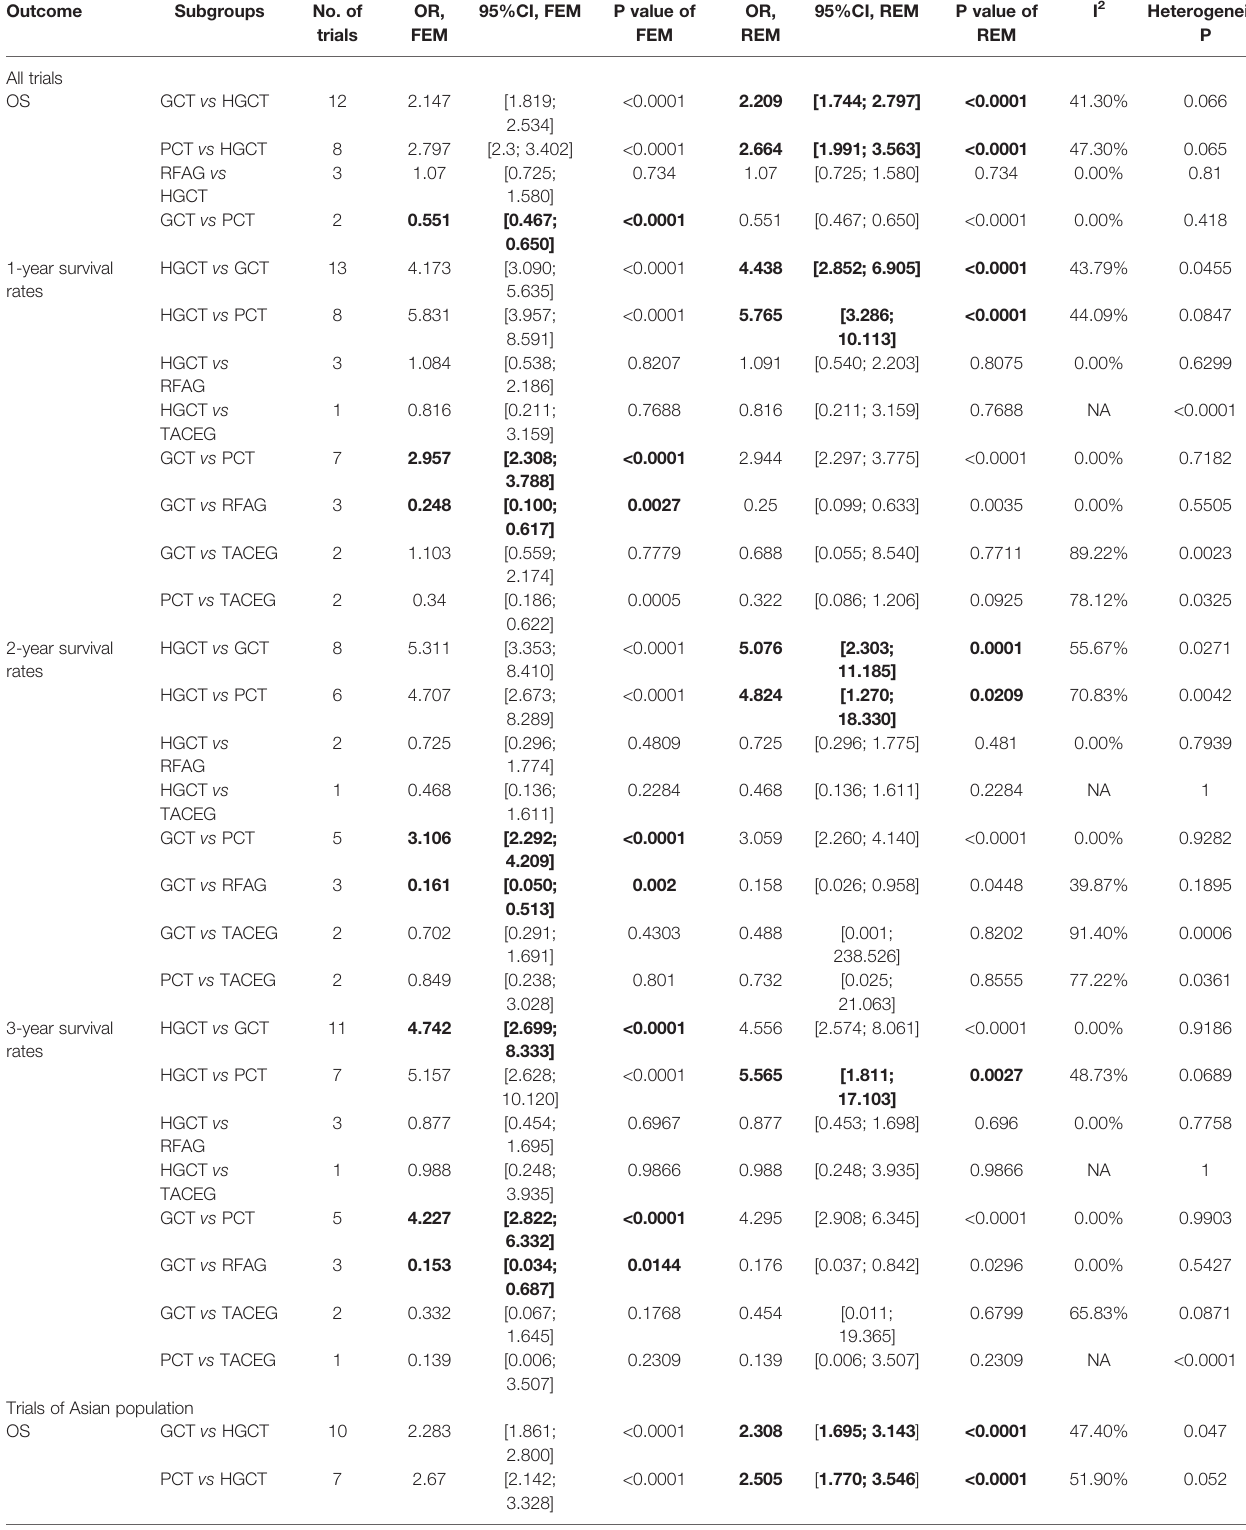
TABLE 2 | Summary estimates for 1-, 2-, 3-year survival rates in meta-analyses of direct comparisons between pairs of Liver-directed treatment and subgroup analysis of Asian for GCLM.